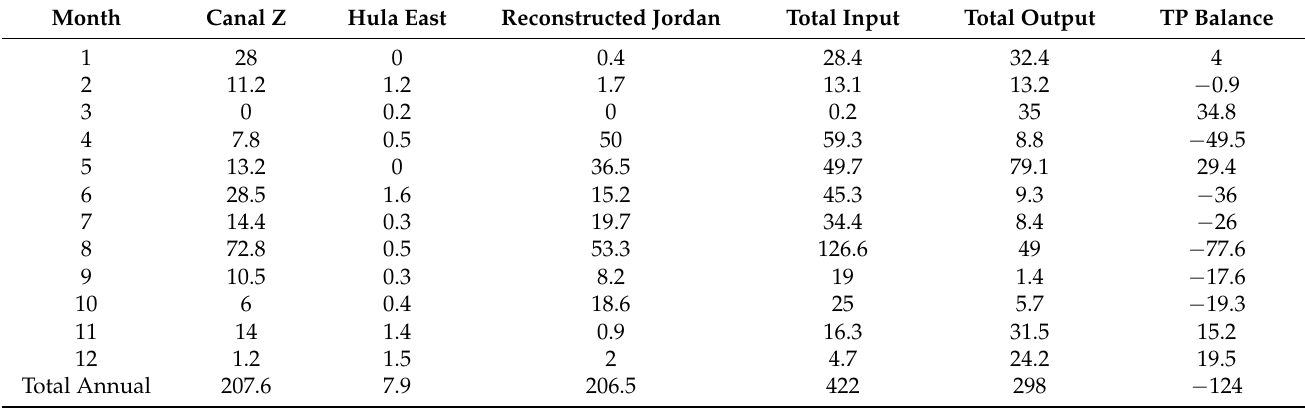
Table 7. Monthly inputs of TP loads (kg/month) into Lake Agmon through major sources of water inflows into Lake Agmon: Canal Z, Hula East, and Reconstructed Jordan during